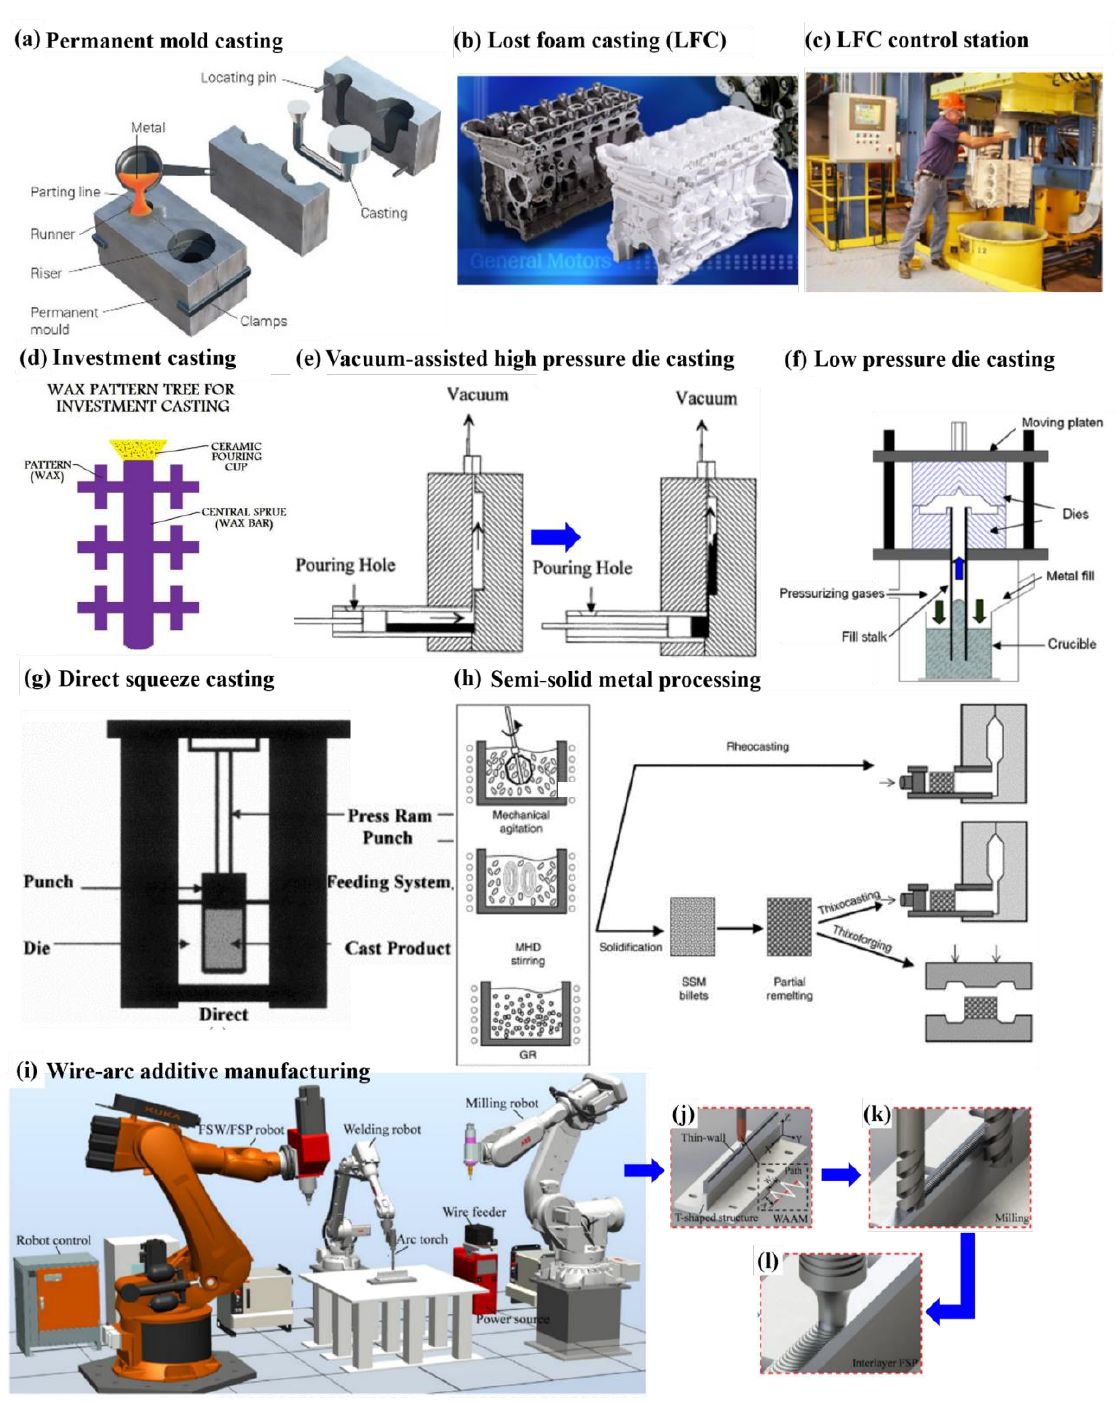
Figure 3. ( a ) Schematic diagram for gravity die-casting using a permanent mold [63]. ( b ) Lost foam pattern with Al engine block casting and ( c ) lost foam control station [2]. ( d ) Wax pattern tree for investment casting [70]. Schematic of ( e ) vacuum-assisted high-pressure die-casting [76], and ( f ) typical anti-gravity low-pressure die-casting arrangement [88]. ( g ) Schematic of direct